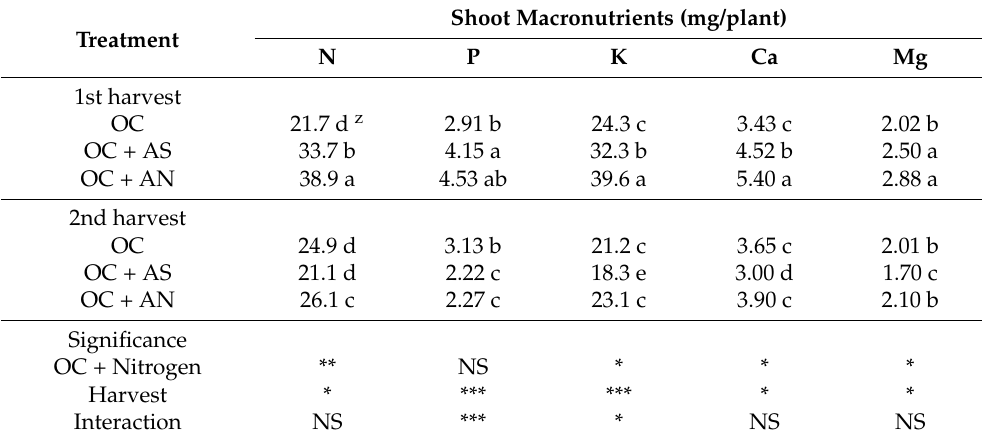
Table 3. Effect of organic compost combined with inorganic nitrogen fertigation on shoot N, P, K, Ca, and Mg